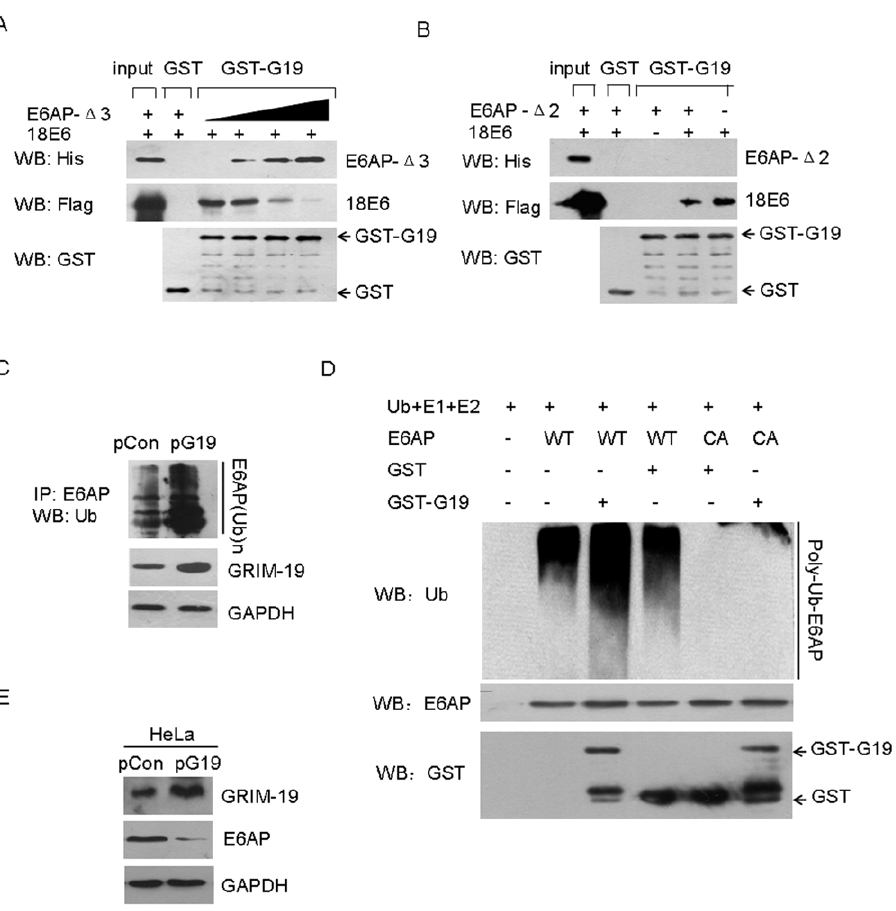
Figure 4. GRIM-19 disrupted E6/E6AP complex and augment E6AP ubiquitination and degradation. ( A ) Competitive assays were performed to analyze the binding of 18E6 to GST-GRIM-19 fusion protein in presence of increasing amounts of E6AP- D 3 ranging from 0–6 m g. ( B ) Pull-down experiments to determine the binding of 18E6 to GST-GRIM-19 proteins. Where indicated E6AP- D 2 proteins (10 ug) were added into GST Pull-down reaction. ( C ) GRIM-19 augmented E6AP degradation in vivo . Before harvesting the cells were treated with MG132 for 4 h, and immunoprecipitation with E6AP antibody was performed. Western blotting of the IP products was using ubiquitin antibody. GAPDH antibodies were used to determine the comparable loading. ( D ) In vitro E6AP ubiquitination assay. Human recombinant ubiquitin, E1, E2 (UbcH5c), batereria- expressed and purified GST and GTS-GRIM-19, E6AP (wild-type or catalytically inactive mutant CA) from wheat germ extract were mixed for in vitro E6AP ubiquitination assay and immunoblotted with ubiquitin antibody. ( E ) Whole cell lysates from HeLa cells expressing the indicated expression plasmids were Western blotted with the indicated antibodies.